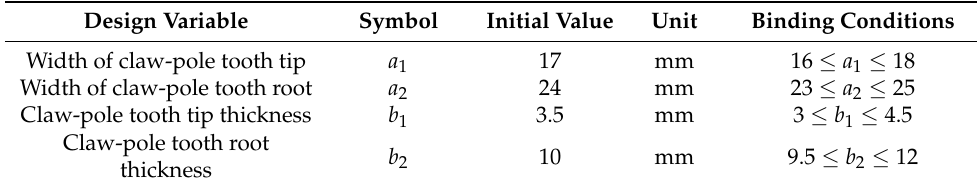
Table 2. Optimization constraints of each design variable.